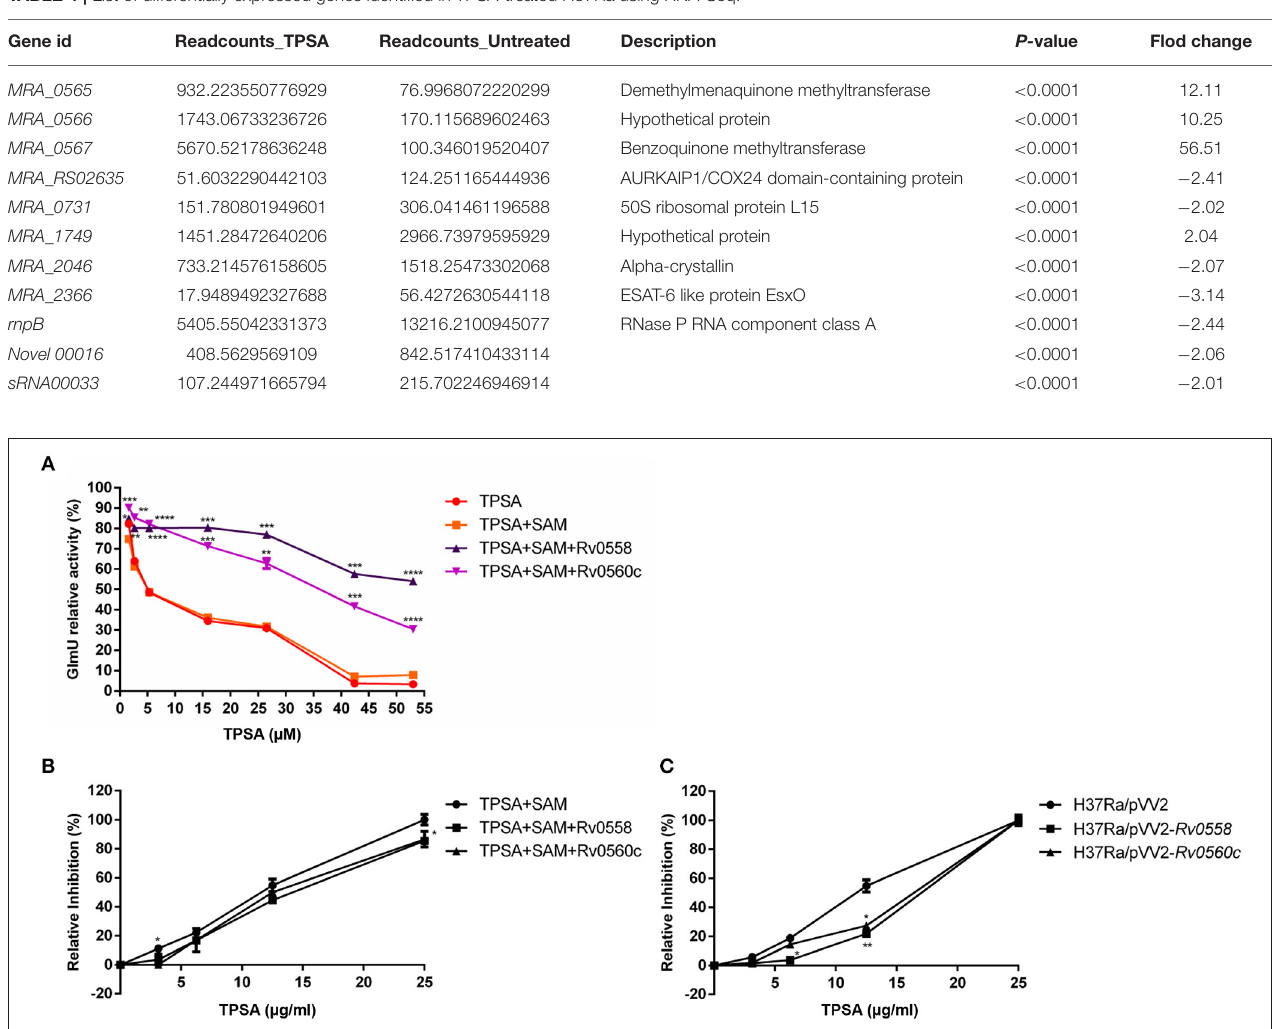
FIGURE 7 | Detection of GlmU relative activity (A) and relative inhibition of H37Ra growth (B) when treated with TPSA and SAM-dependent methylation of TPSA by Rv0558 protein and Rv0560c protein. Detection of relative growth inhibition of H37Ra/pVV2- Rv0558 and H37Ra/pVV2- Rv0560c strain as well as H37Ra/pVV2 strain as a control when treated with different concentrations of TPSA (C) . Differences among the groups were calculated by unpaired two-tailed t -test. * P < 0.05; ** P < 0.01; *** P < 0.001; **** P < 0.0001 [In (A) , the P- values of TPSA + SAM group to TPSA + SAM + Rv0558 group for 1.59 µ M, P = 0.0174; 2.65 µ M, P =